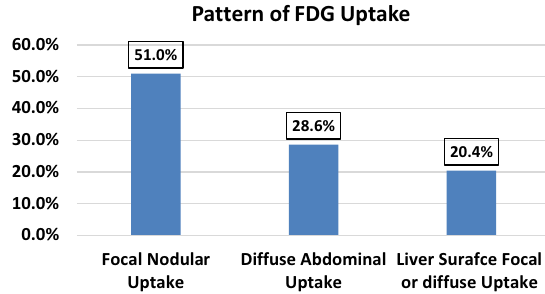
Fig. 4 Column chart showing the distribution of the studied cases according to pattern of FDG uptake